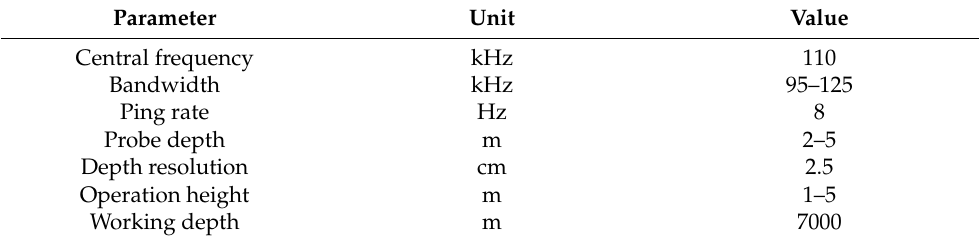
Table 9. HFSSP specifications.